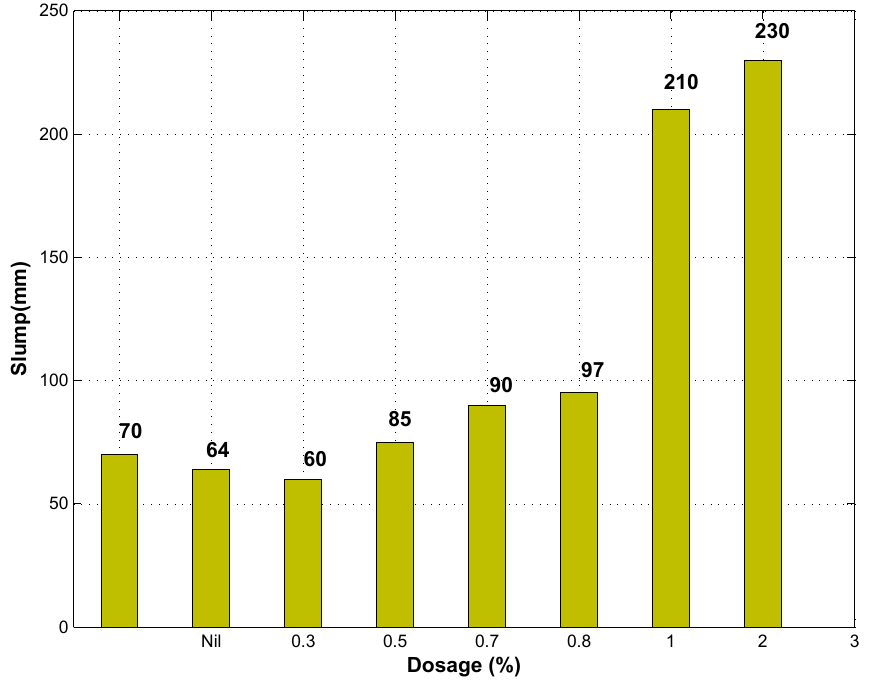
Figure 3. Slump of concrete with different dosages of Gum from Acacia karroo (GAK).